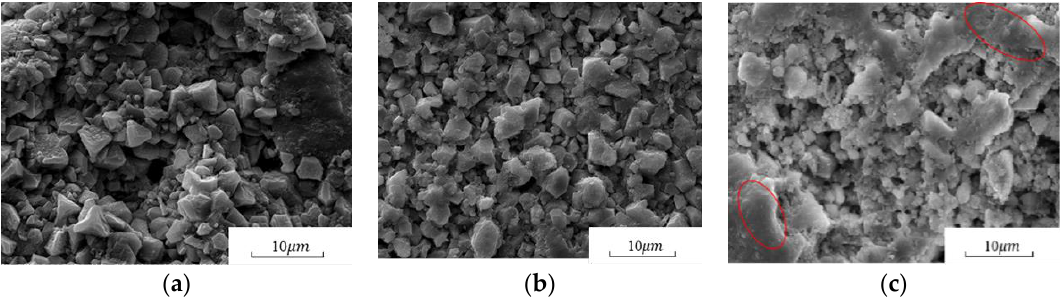
Figure 7. Effect of coatings on the SEM images of hardened cement paste: ( a ) Uncoated specimens; ( b ) PC1; ( c ) CL1.